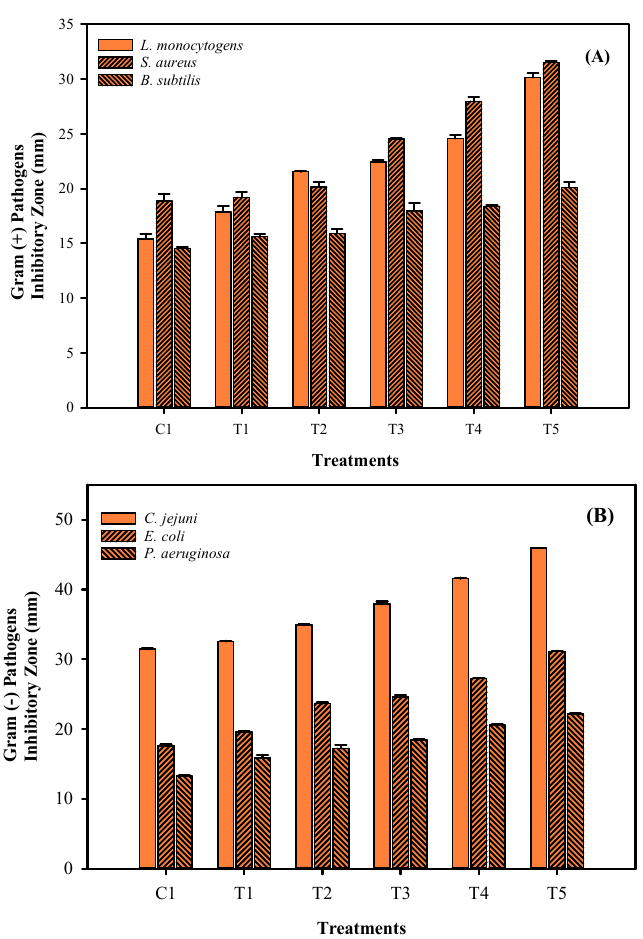
Figure 5. Antimicrobial activities (gram (+) pathogen inhibition ( A ) and gram ( − ) pathogen inhibition ( B )) of the mung bean phyto-film incorporated with LPE and was processed under sonication.